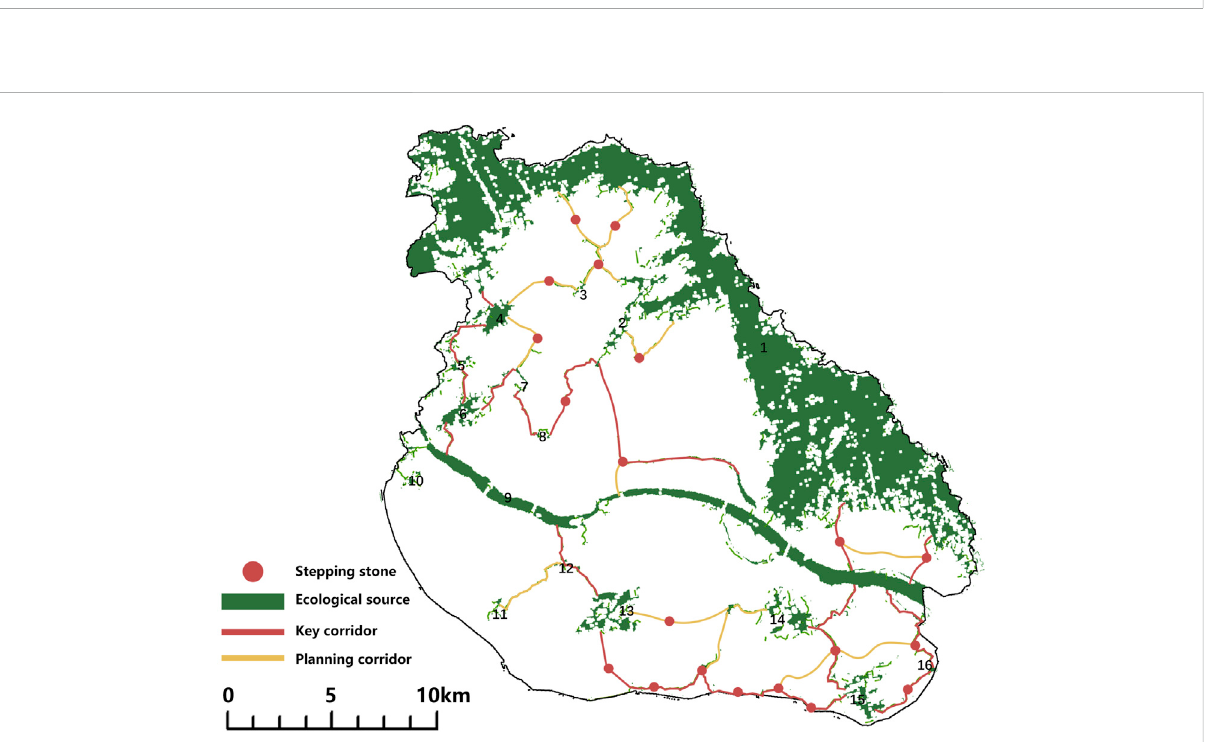
FIGURE 10 Ecological cost distance.